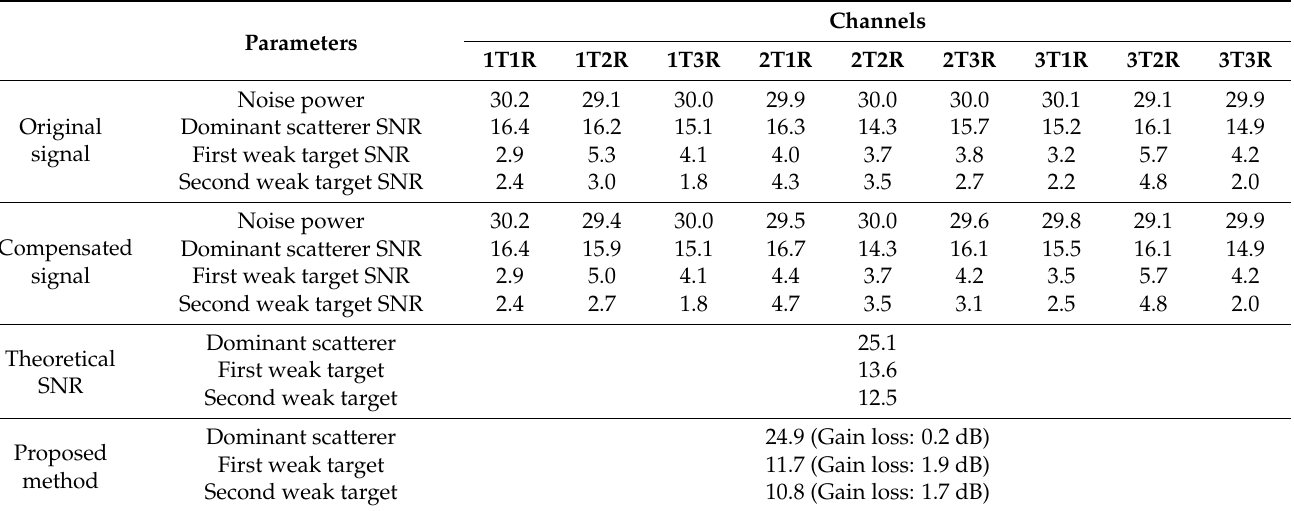
Table 5. The numerical comparison results (dB) of